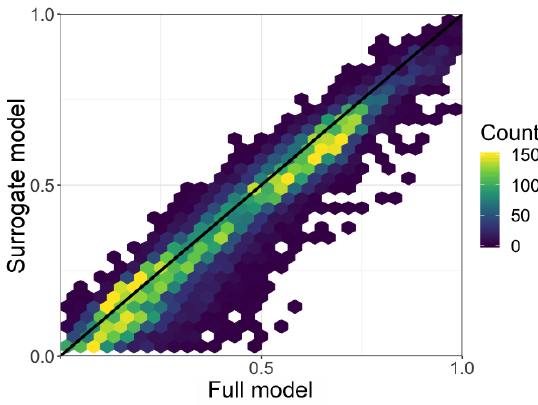
Figure 7. The annual grid box average fraction of light-saturated leaves as simulated by the full and surrogate models throughout the canopy for the year 2012. The color bar represents the number of observations in a given hex. The 1 : 1 line is shown in